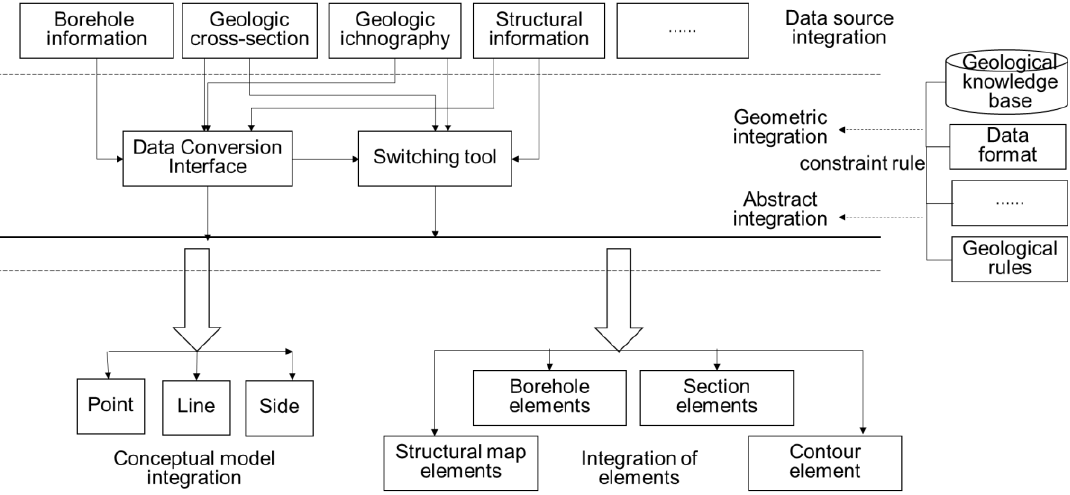
Figure 3. Theoretical method framework of multisource data integration based on geological knowledge [5].